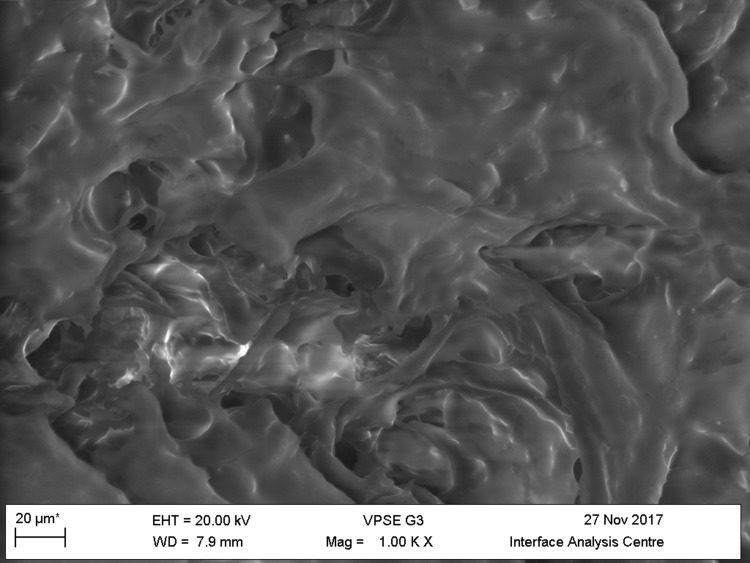
Demineralised modern chicken bone viewed close up (image 1).